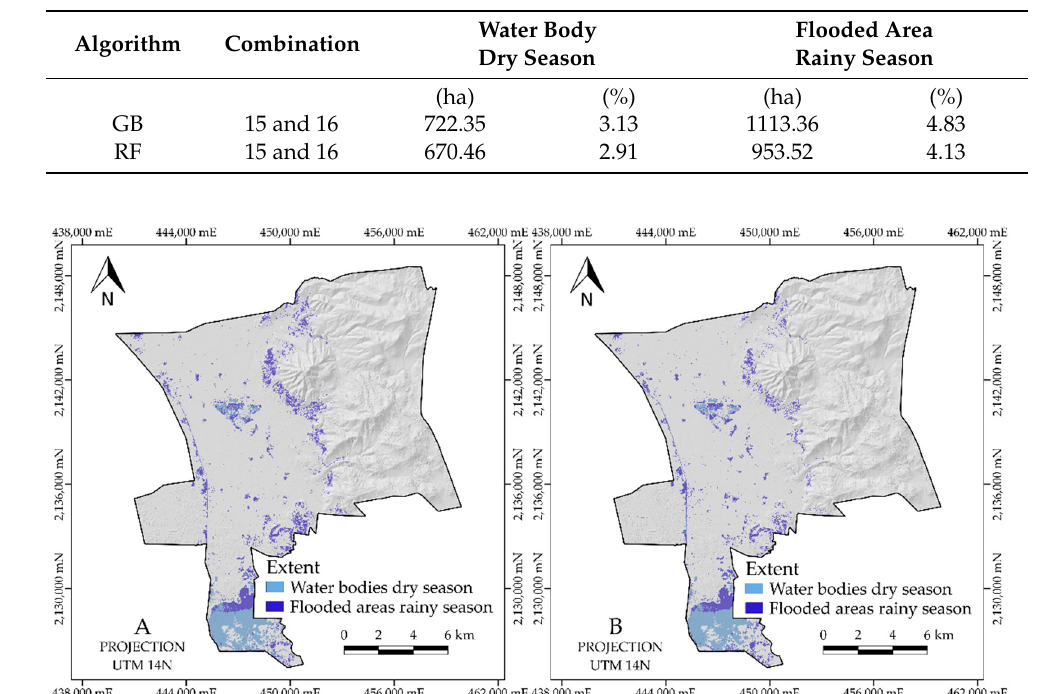
Figure 9. ( A ) Elevation distribution over the study area (DEM from LiDAR) and ( B ) depth of flooded areas. 4. Discussion The presence of clouds, fog, and atmospheric particles in Sentinel-2 optical images can place limitations on detecting phenomena during rainy periods, as such conditions decrease solar illumination. During image processing, it is necessary to homogenize the histograms and normalize values of the RGB composite [63]. In SAR image processing, backscatter values are converted to backscatter coefficients (dB) to increase scene contrast and enhance visual differences between target classes.